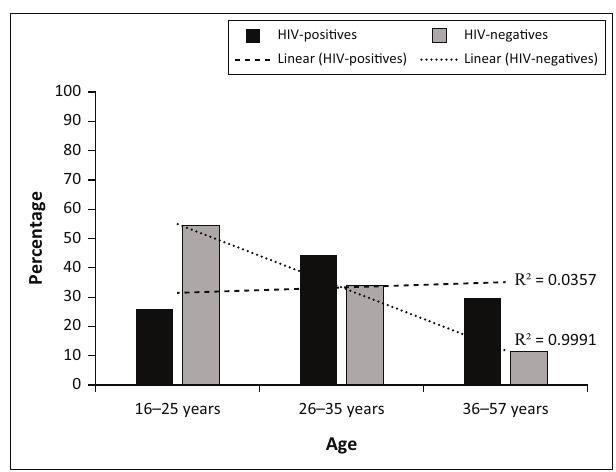
FIGURE 1: Human immunodeficiency virus status according to age groups among women and men with genital ulcer disease.